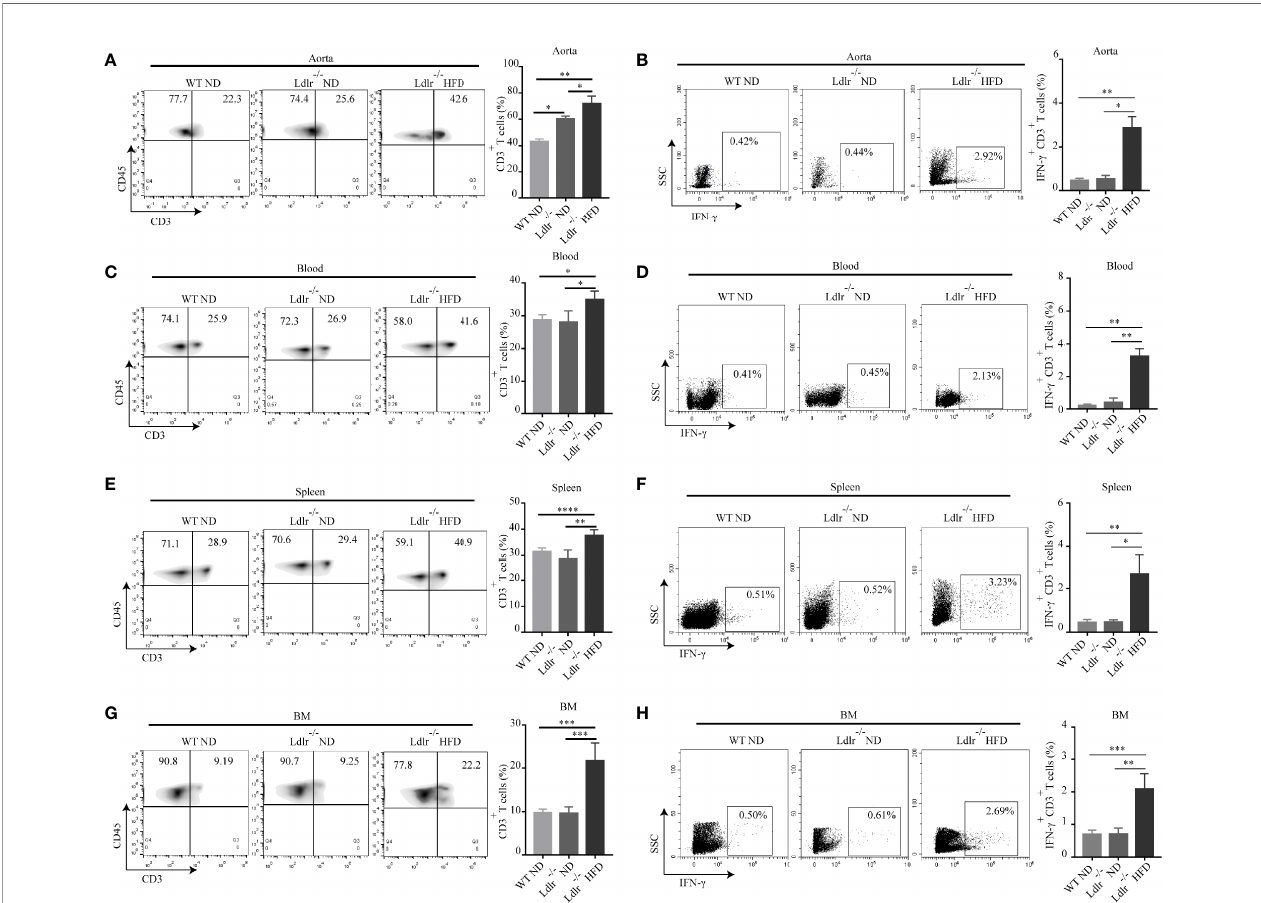
FIGURE 6 | Percentages of CD3 + T cells and IFN- g + T cells are higher in LDLr -/- HFD mice compared to control groups. The distribution of CD3 + T and IFN- g + T cell in the (A, B) aorta, (C, D) blood, (E, F) spleen (SP), and (G, H) bone marrow (BM) of WT ND, LDLr -/- ND and LDLr -/- HFD mice were measured by fl ow cytometry. *p < 0.05, **p < 0.01, ***p < 0.001, ****p <